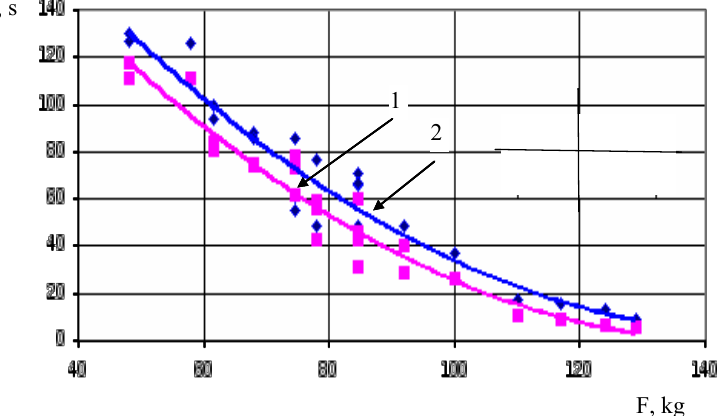
Fig.2. Dependence of maximal time of hanging on bar (t lim ) on body mass (F) [9]: 1 – left hand 2 – right hand